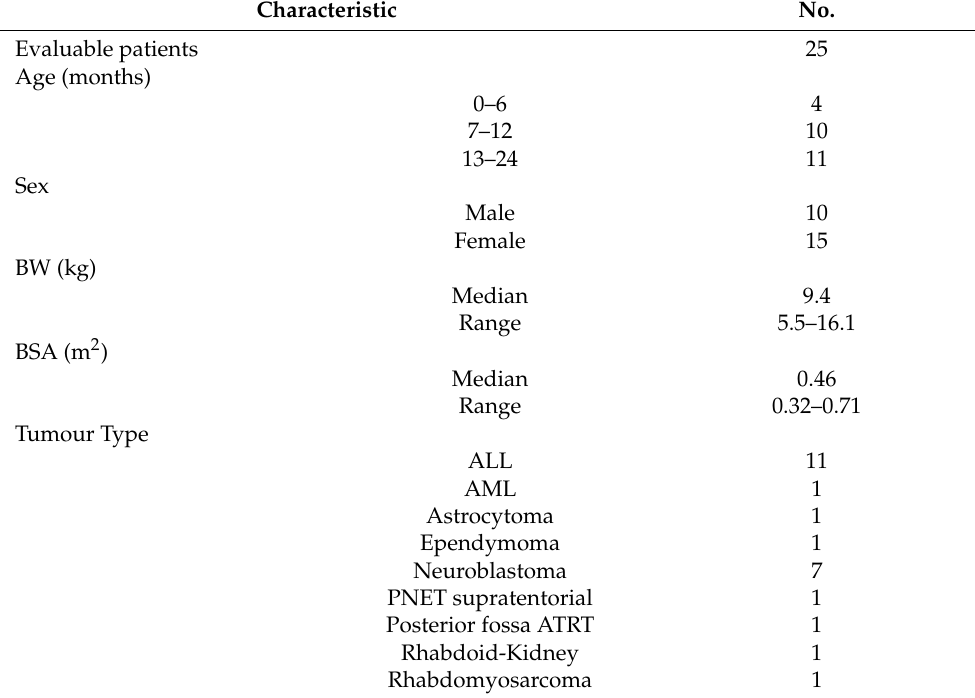
Table 1. Patient